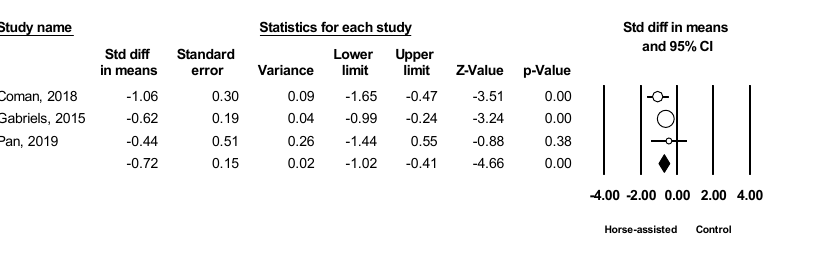
Figure 2. Forest plot showing the effects of horse-assisted therapy vs. control on social communication [43,44,46].